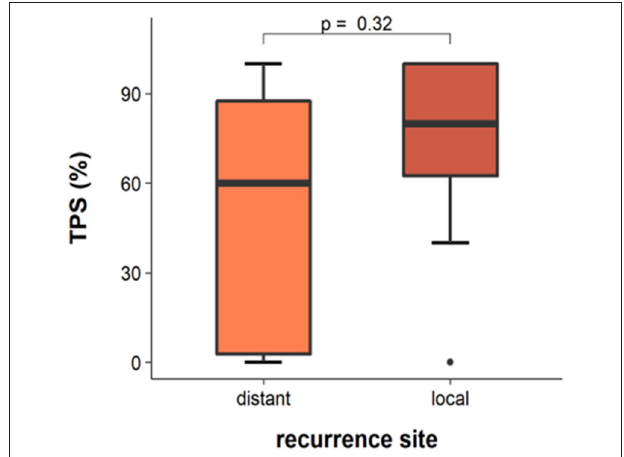
FIGURE 3 | DLL3 expression in chemorelapsed samples in dependency of site of recurrent